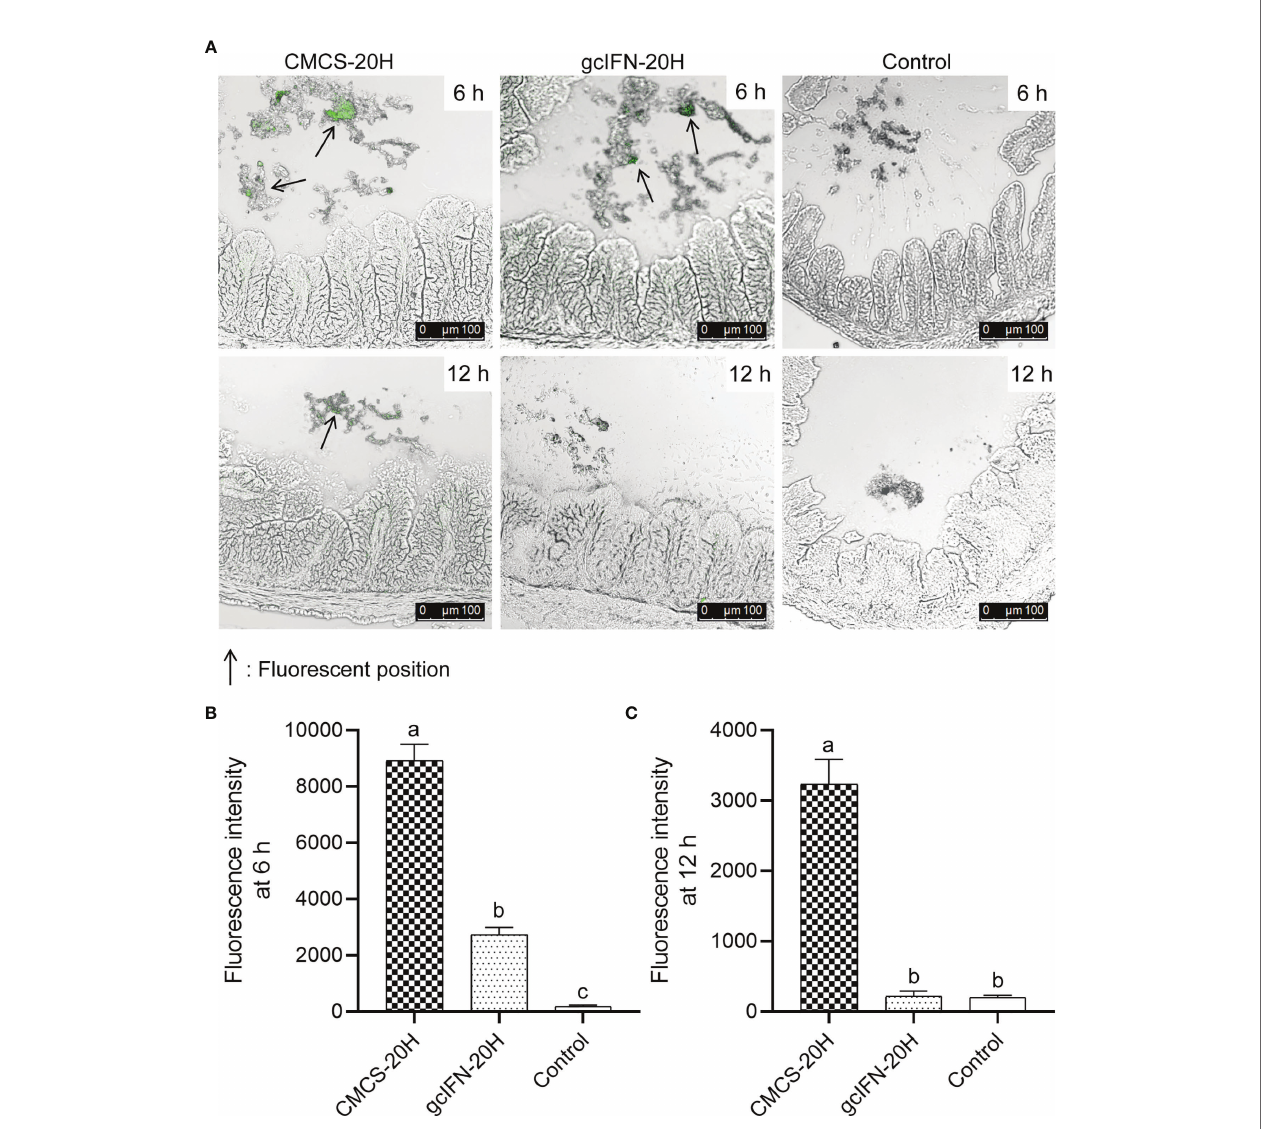
FIGURE 2 | The antidegradation ef fi cacy of CMCS-20H in intestine. (A) Fluorescence microscopic images of intestine section of grass carp. CMCS-20H and gcIFN-20H were poured into the foregut, and the hindgut was taken at 6 and 12 h to make frozen sections. The green fl uorescence indicates the gcIFN-20H. (B , C) Fluorescence intensity analysis of intestine section at 6 and 12 h. Fluorescence intensity was analyzed by ImageJ software. Data are presented as means ± SD ( n = 4). Different lowercase letters in each group (a, b, and c) denote signi fi cant variations suggested by the Kruskal-Wallis statistics followed by the Dunn ’ s multiple comparison (p <